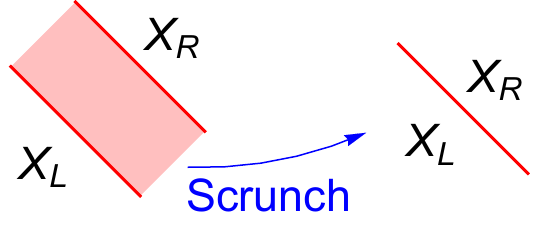
Figure 6 . Scrunching a region of (1 + 1) -dimensional spacetime into a light-like